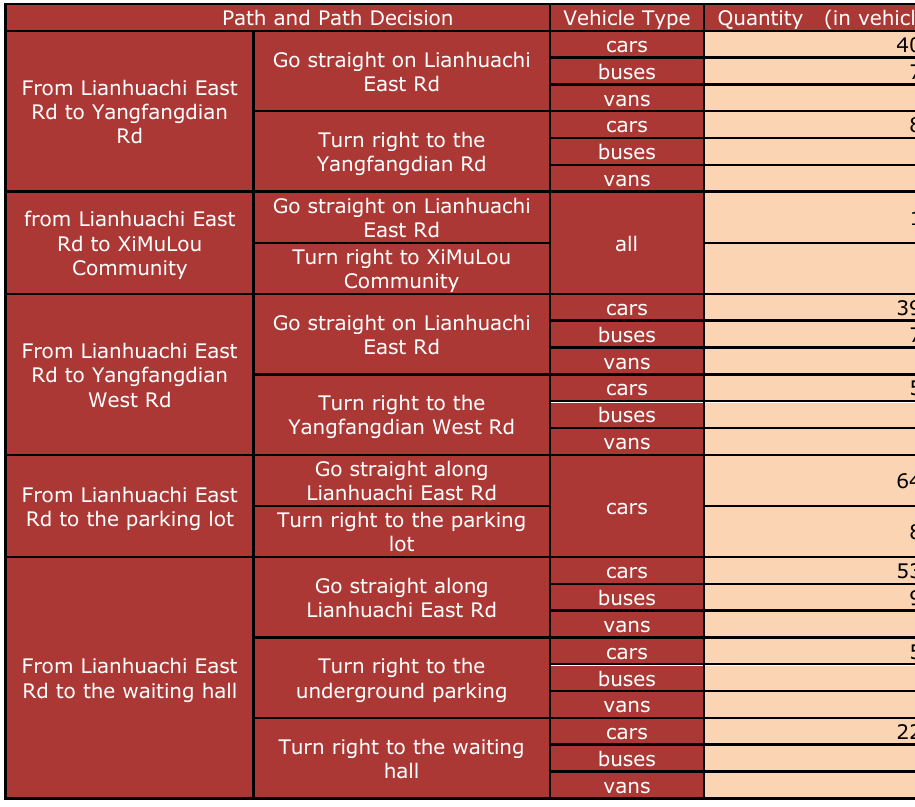
Table 3. Path Decision